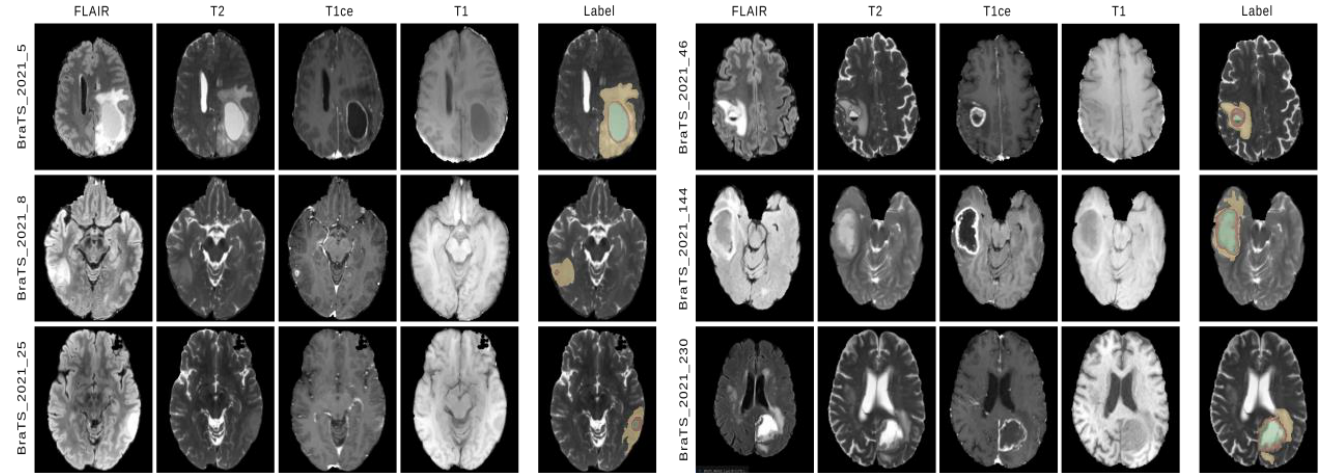
Figure 2. Illustration of six samples of multi-parametric MRI images (slice containing tumor region) from the BraTS 2021 dataset depicting Flair, T2, T1ce, T1 modalities, and label. The yellow, green, and red regions on the label indicate the tumor regions of different levels.